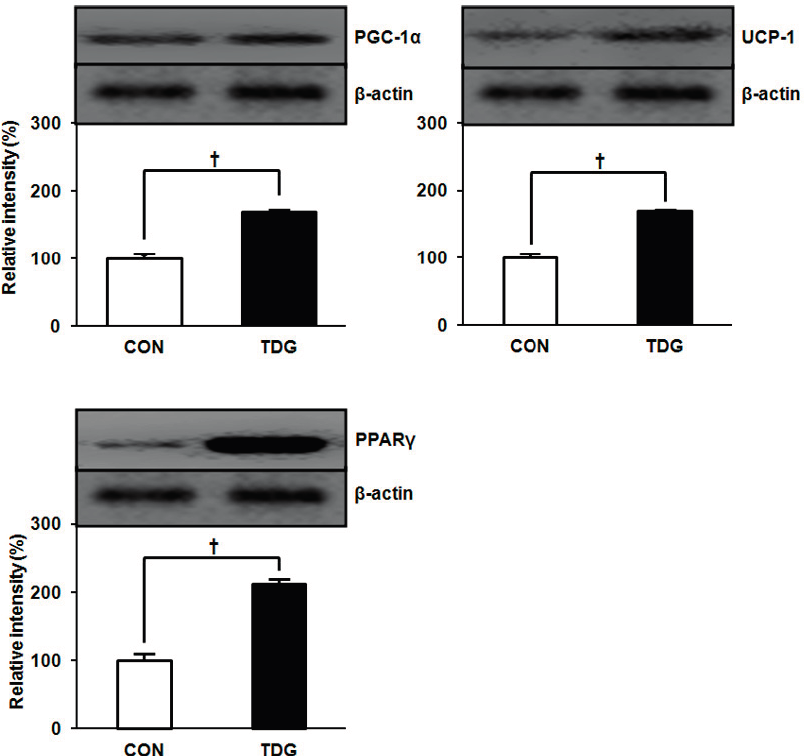
Figure 6. Comparison of expression patterns of thermogenic marker proteins in WAT between control and TDG-treated rats. For full names of each protein, see abbreviation section. Band intensity was estemated by ImageMaster 2-DE software. Statistical significance was determined by Student’s t -test, where p values are † p <